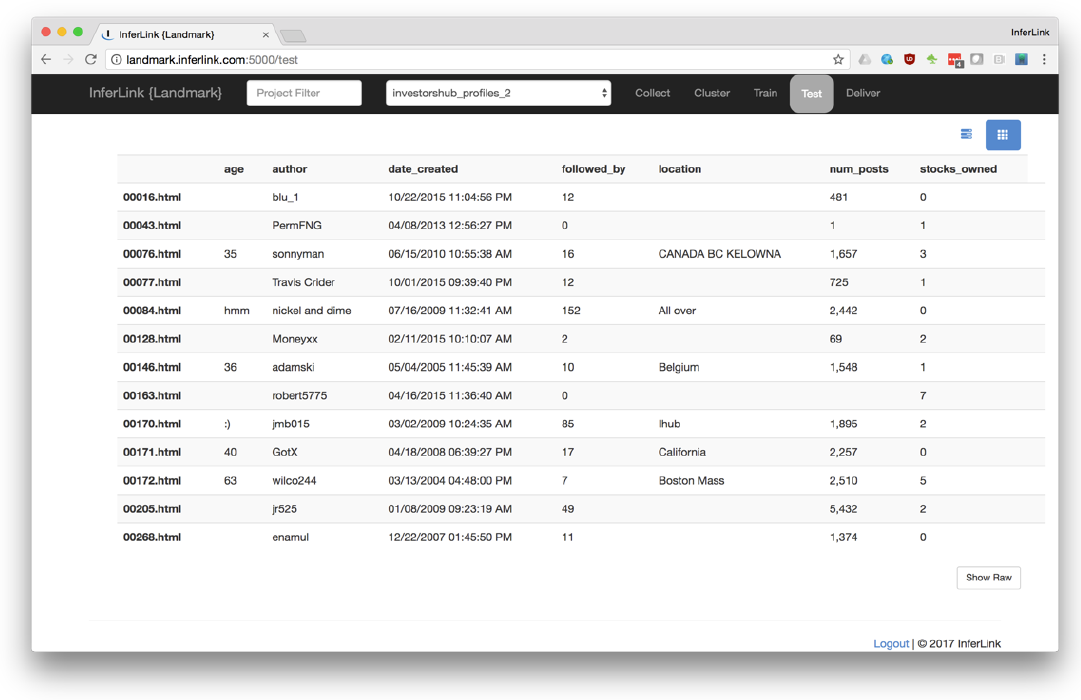
Figure 3. An illustration of the semantic typing facility in Inferlink. In this illustration, semantic typing has already been